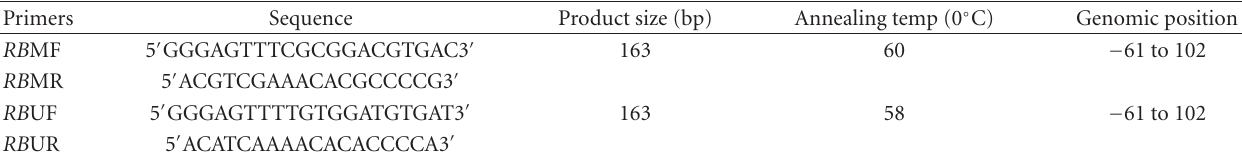
Table 1: List of primers used in MSP.